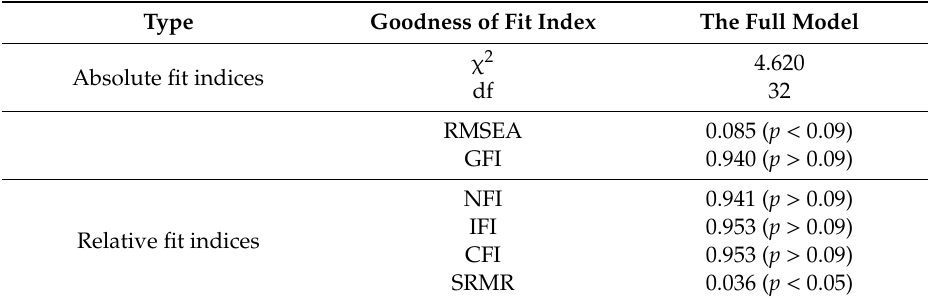
Table 2. The goodness-of-fit index of structural equation modeling for the hypothesized